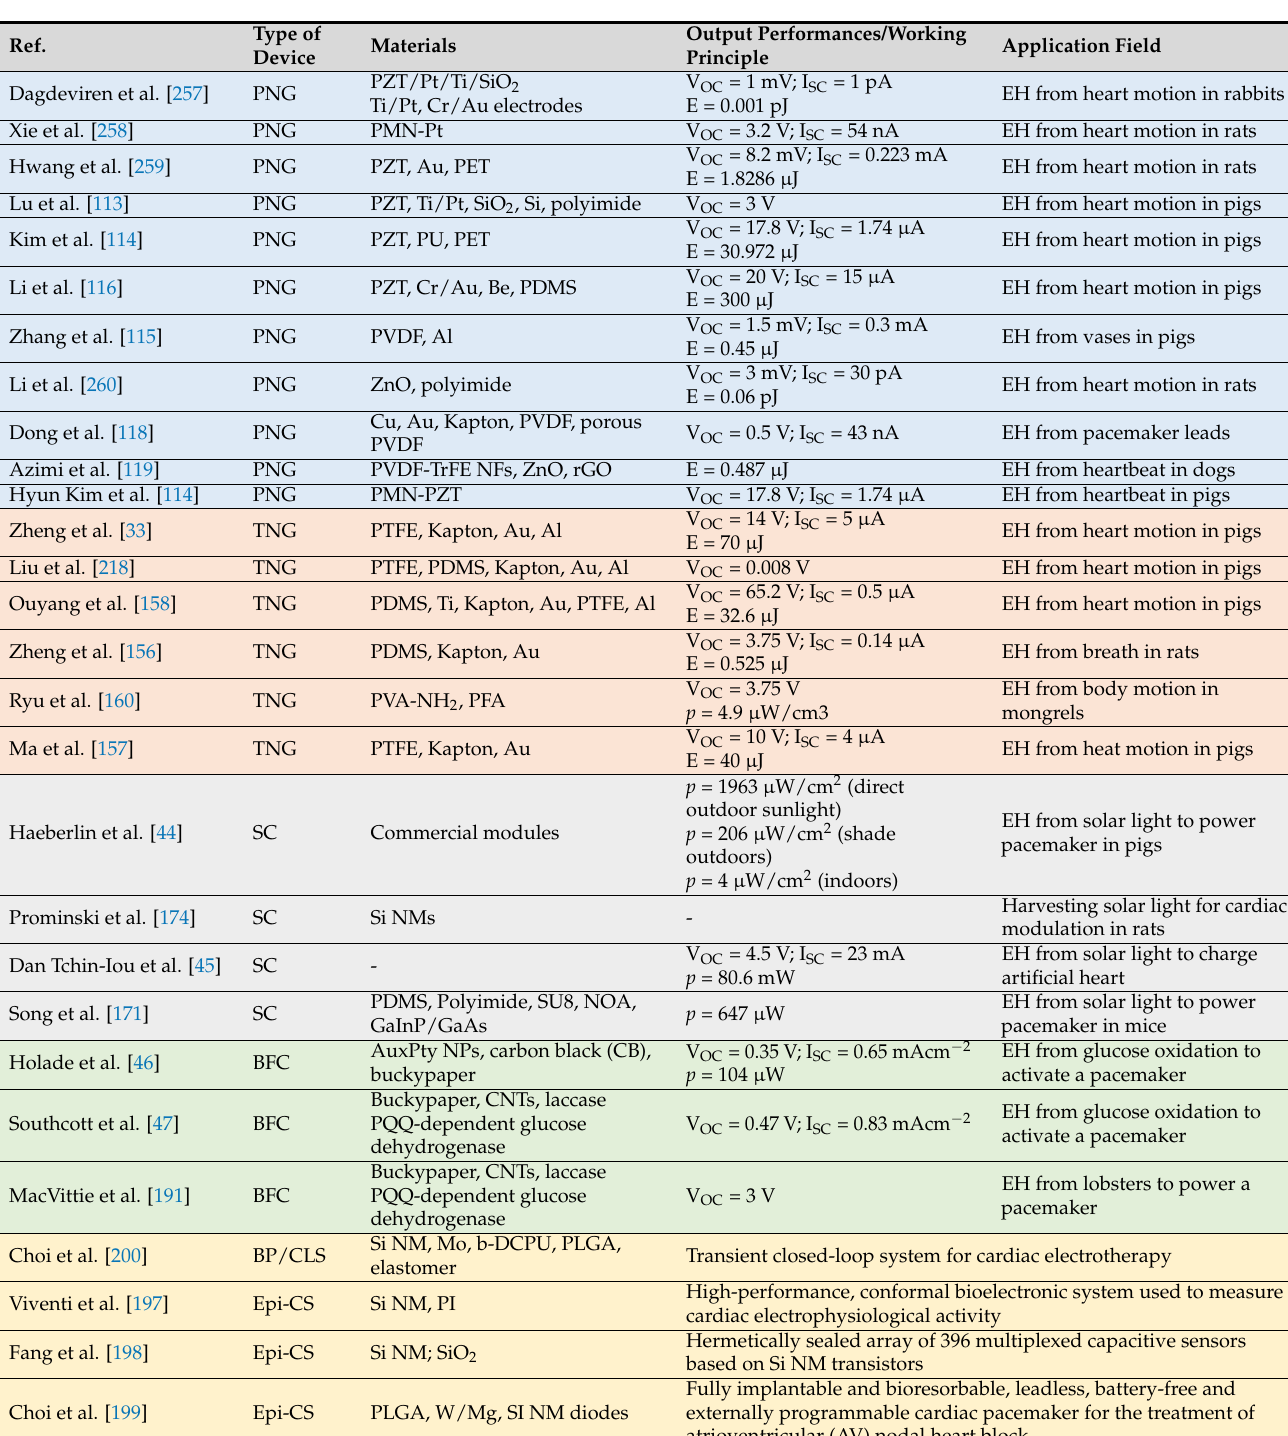
Table 2 lists the main examples from previous literature for all the aforementioned devices for cardiac bioelectronic interfaces. Table 2. Cardiac bioelectronic devices, classified in terms of materials, performances, and applicative context. The blue, pink, grey, green, and yellow colors are, respectively, for: piezoelectric nanogen- erator (PNG), triboelectric nanogenerator (TNG), solar cells (SCs), electrochemical generators and biofuel cells (BFCs), and cardiac bioelectronic